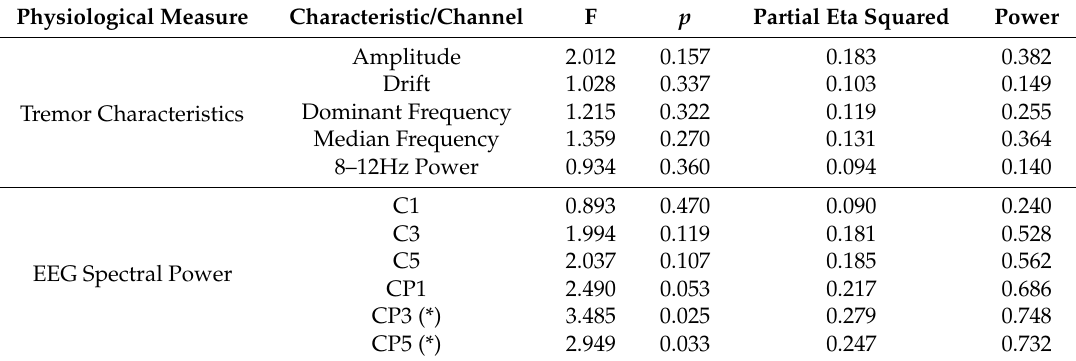
Table 1. Statistical results for each variable describing the tremor characteristics and the EEG spectral analysis for electrodes C1, C3, C5, CP1, CP3 and CP5. All results are corrected using the Greenhouse–Geisser